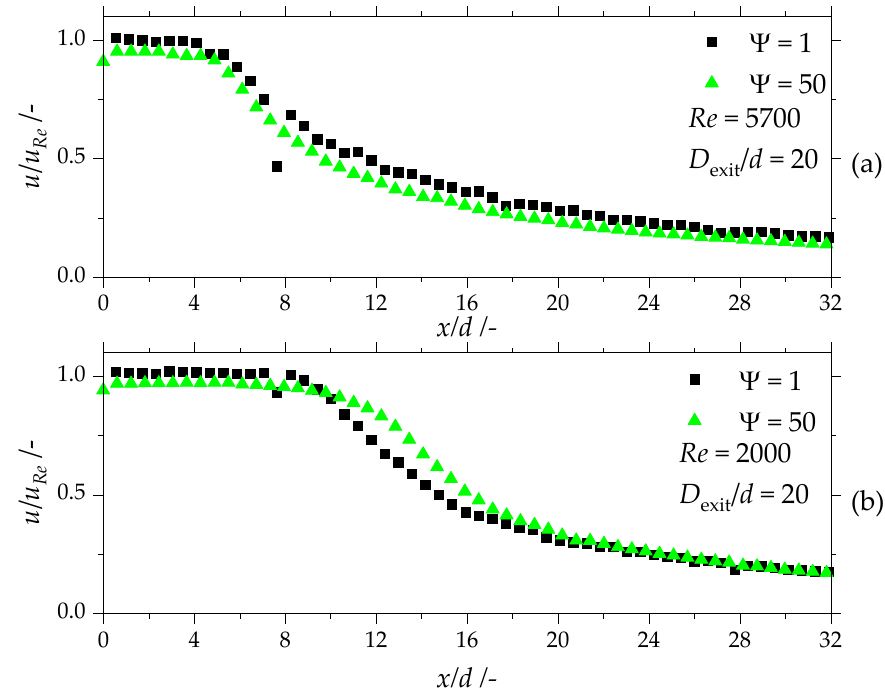
Figure 6. ( a ) Normalized velocity on the center axis at a Reynolds number Re = 5700 at the outlet of an orifice ( Ψ = 1 ) and of a 50-fold scaled orifice ( Ψ = 50 ) with an outlet channel diameter ratio of D exit / d = 20. ( b ) Normalized velocity on the center axis at a Reynolds number Re = 2000 at the outlet of an orifice ( Ψ = 1 ) and of a 50-fold scaled orifice ( Ψ = 50 ) with an outlet channel diameter ratio of D exit / d =